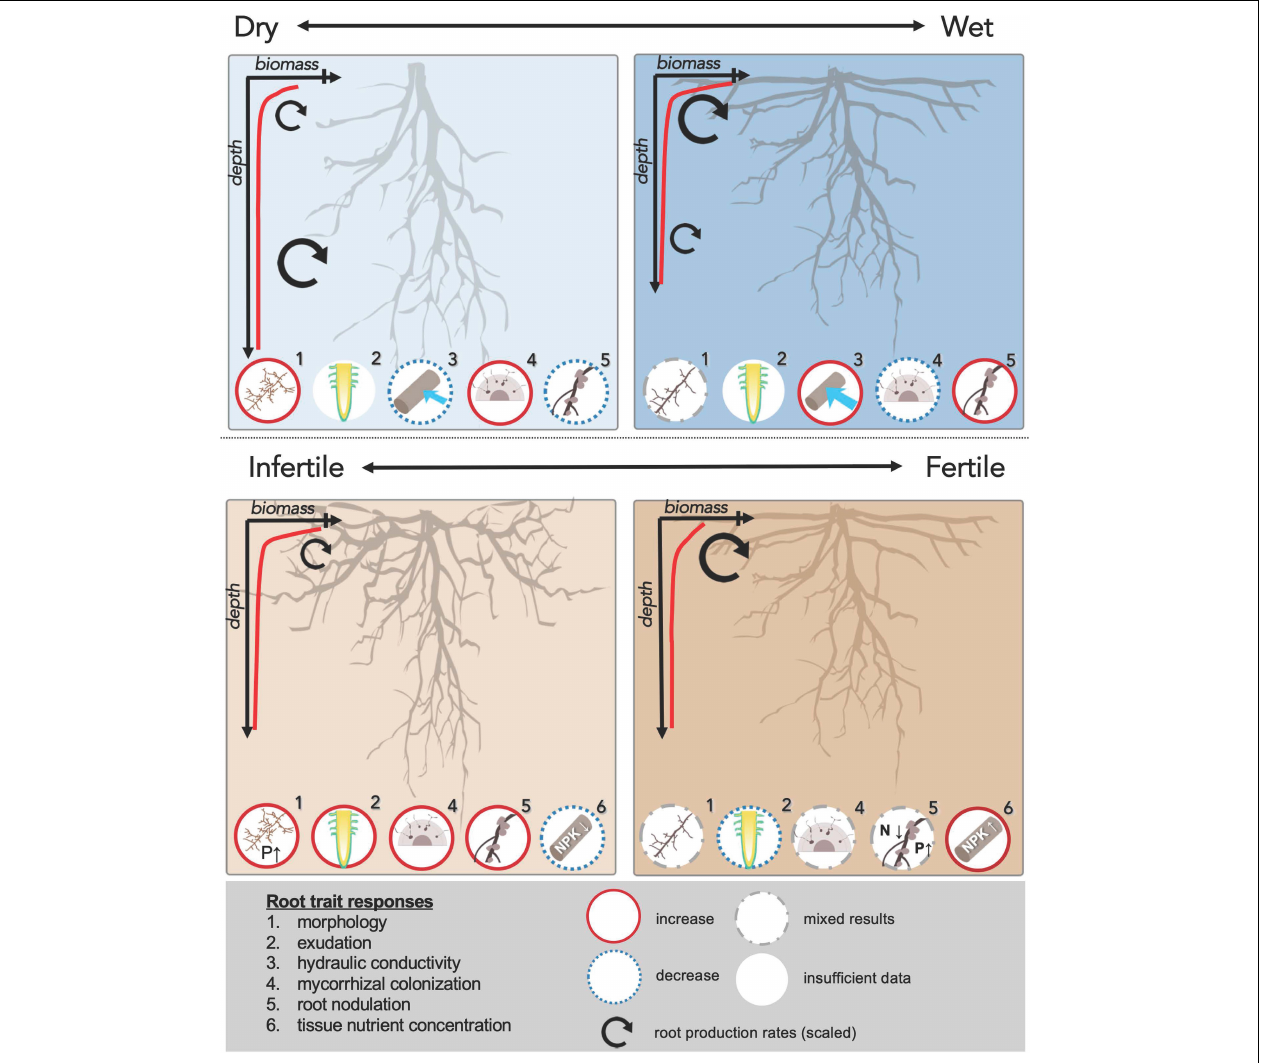
FIGURE 1 | Fine root trait responses to variation in moisture and nutrient availability are shown for tropical forests, following empirical studies in the text. Differences in overall root architecture are shown in each panel, with representative fine root biomass depth distribution curves. Relative differences in fine root production rates are shown as different sized curved arrows for surface soils and subsoils. For example, on the dry-to-wet gradient, wetter sites have shallower root architecture with more surface root biomass, and faster root turnover at the surface but slower root turnover at depth relative to drier sites. Insets show responses of 6 additional fine root traits to the resource conditions, including: (1) root morphology – specific root length per mass (SRL) and/or average diameter; (2) root organic acid and phosphatase enzyme exudates; (3) hydraulic conductance; (4) mycorrhizal colonization rates; (5) root nodulation for N fixing symbionts; (6) fine root tissue content of N, P and K. In the lower panels, circles with N or P and arrows show how increased availability of that nutrient increases or decreases that fine root trait (e.g. increased P increases root SRL in the lower left panel). Missing numbers in some panels are from traits with no relevant data for the gradient shown (e.g., #3 - hydraulic traits - are not shown on the soil fertility gradient). Colored lines around the inset circles indicate: solid line = increase, small dashed line = decrease, mid-dashed line = mixed effects across studies, no line = no data.